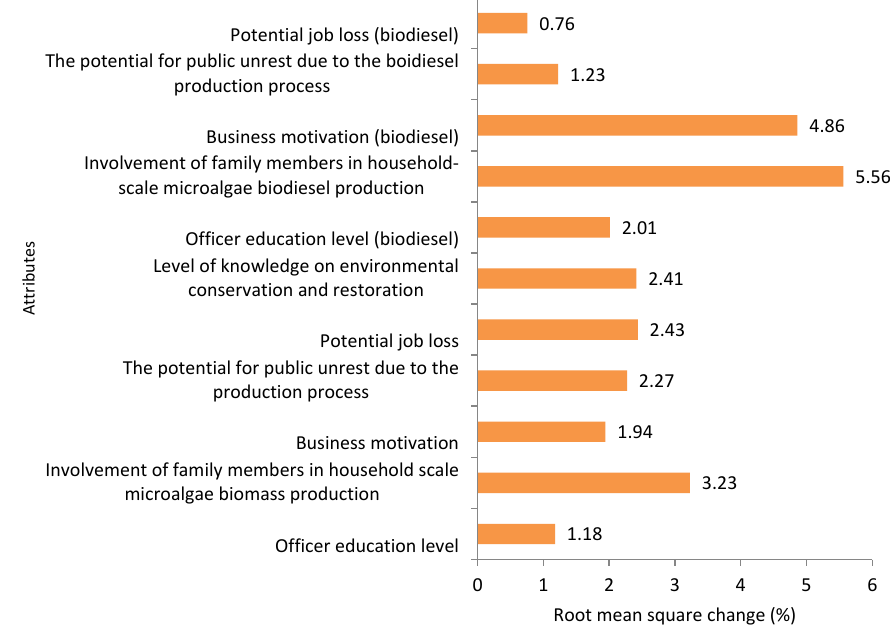
Fig. 3: Leverage of social attributes